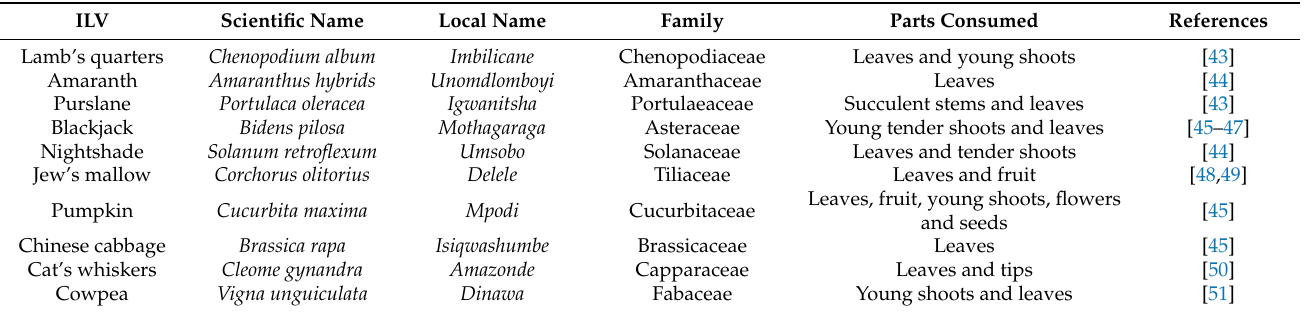
Table 1. Selected indigenous leafy vegetables and their respective edible parts consumed in South Africa and